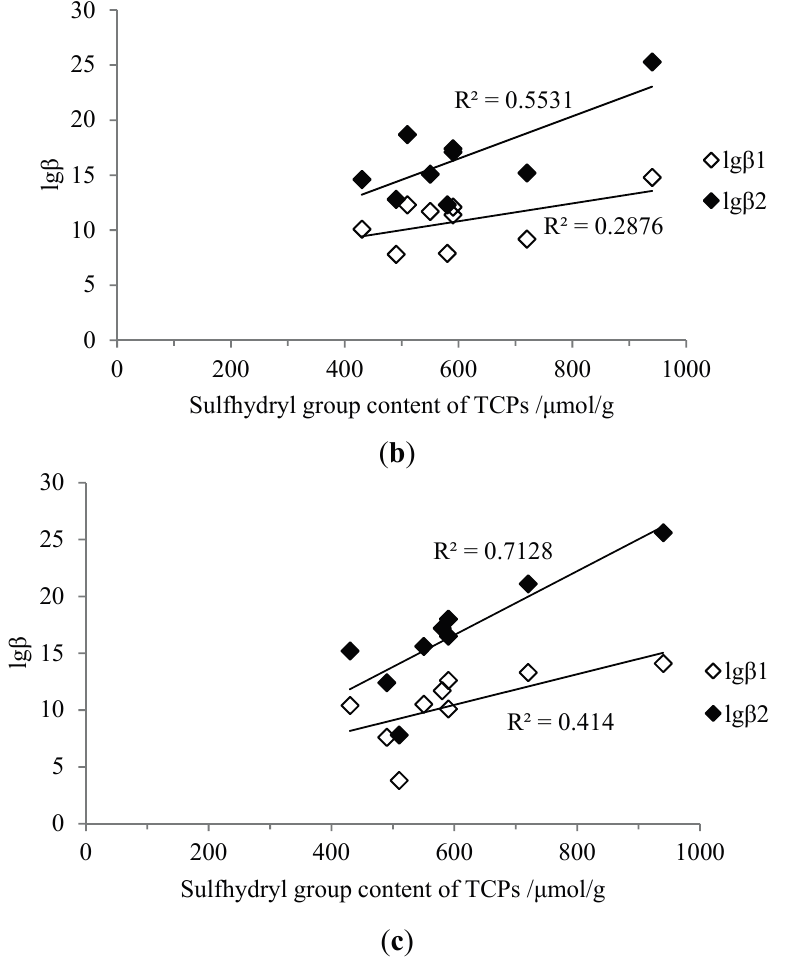
Figure 5. Correlations between content of sulfhydryl group and stability constants. ( a ) Hg 2+ ; ( b ) Cd 2+ ; ( c ) Pb 2+